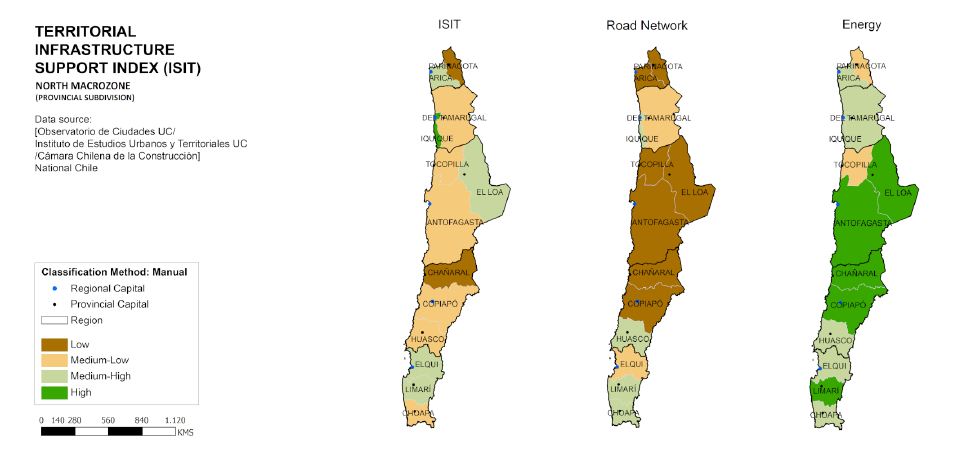
Figure 2: ISIT of provinces of the northern